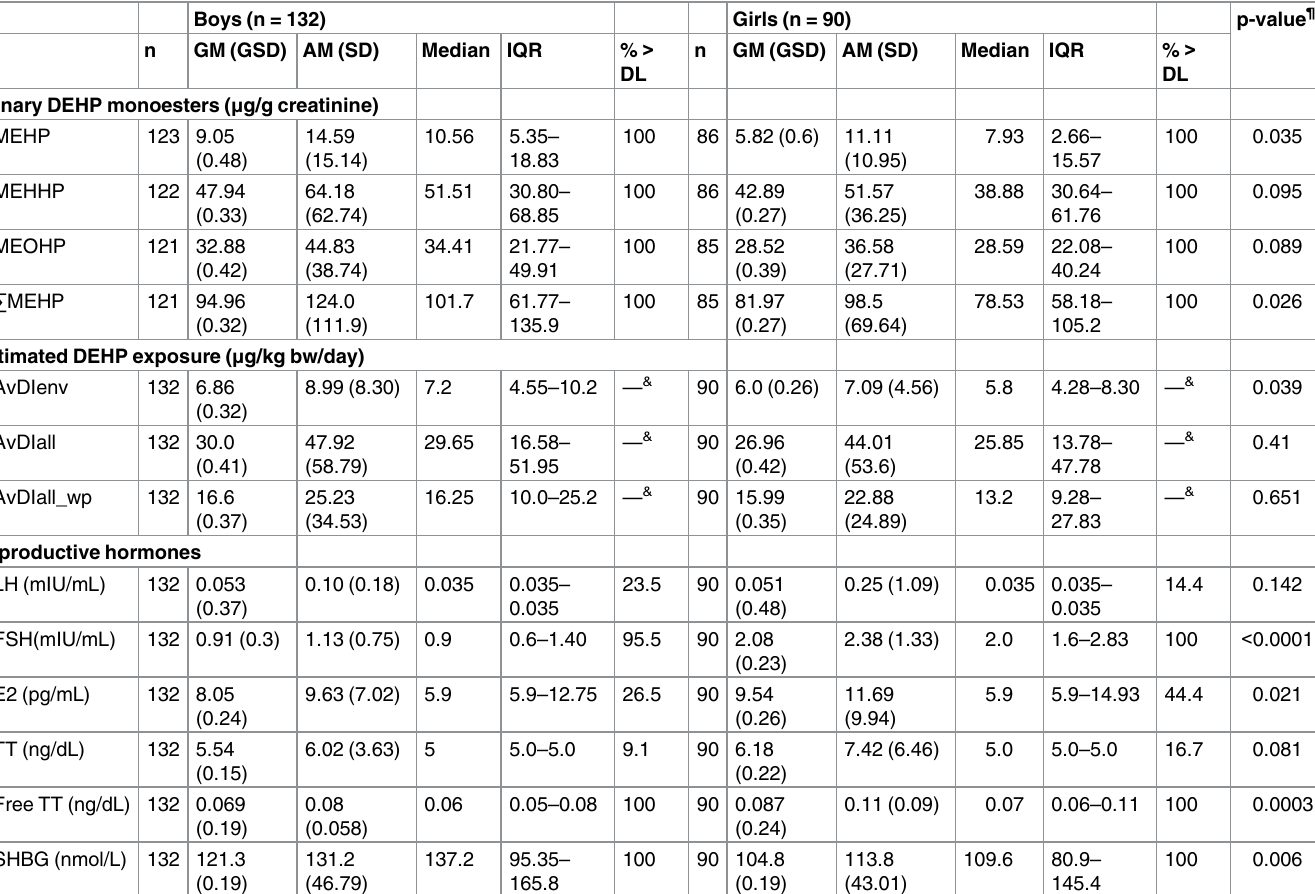
Table 2. Concentration of urinary DEHP metabolites, estimated DEHP exposure, and reproductive hormones in participants by sex (n =